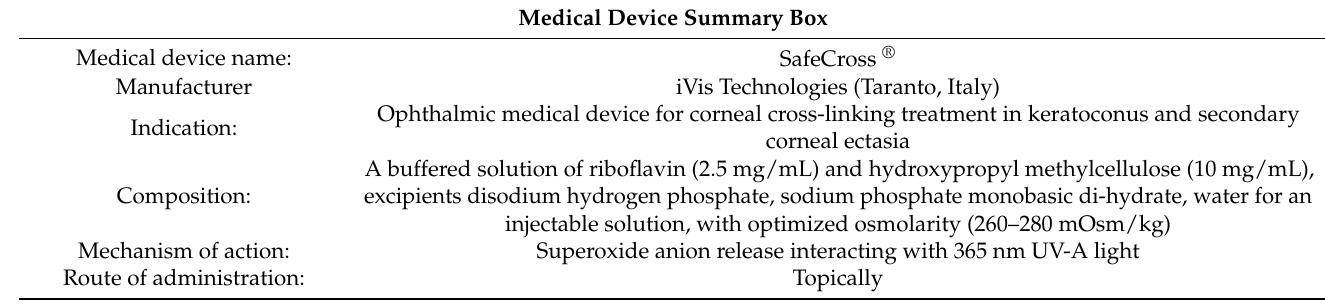
Table 1. Medical device summary box. Medical Device Summary